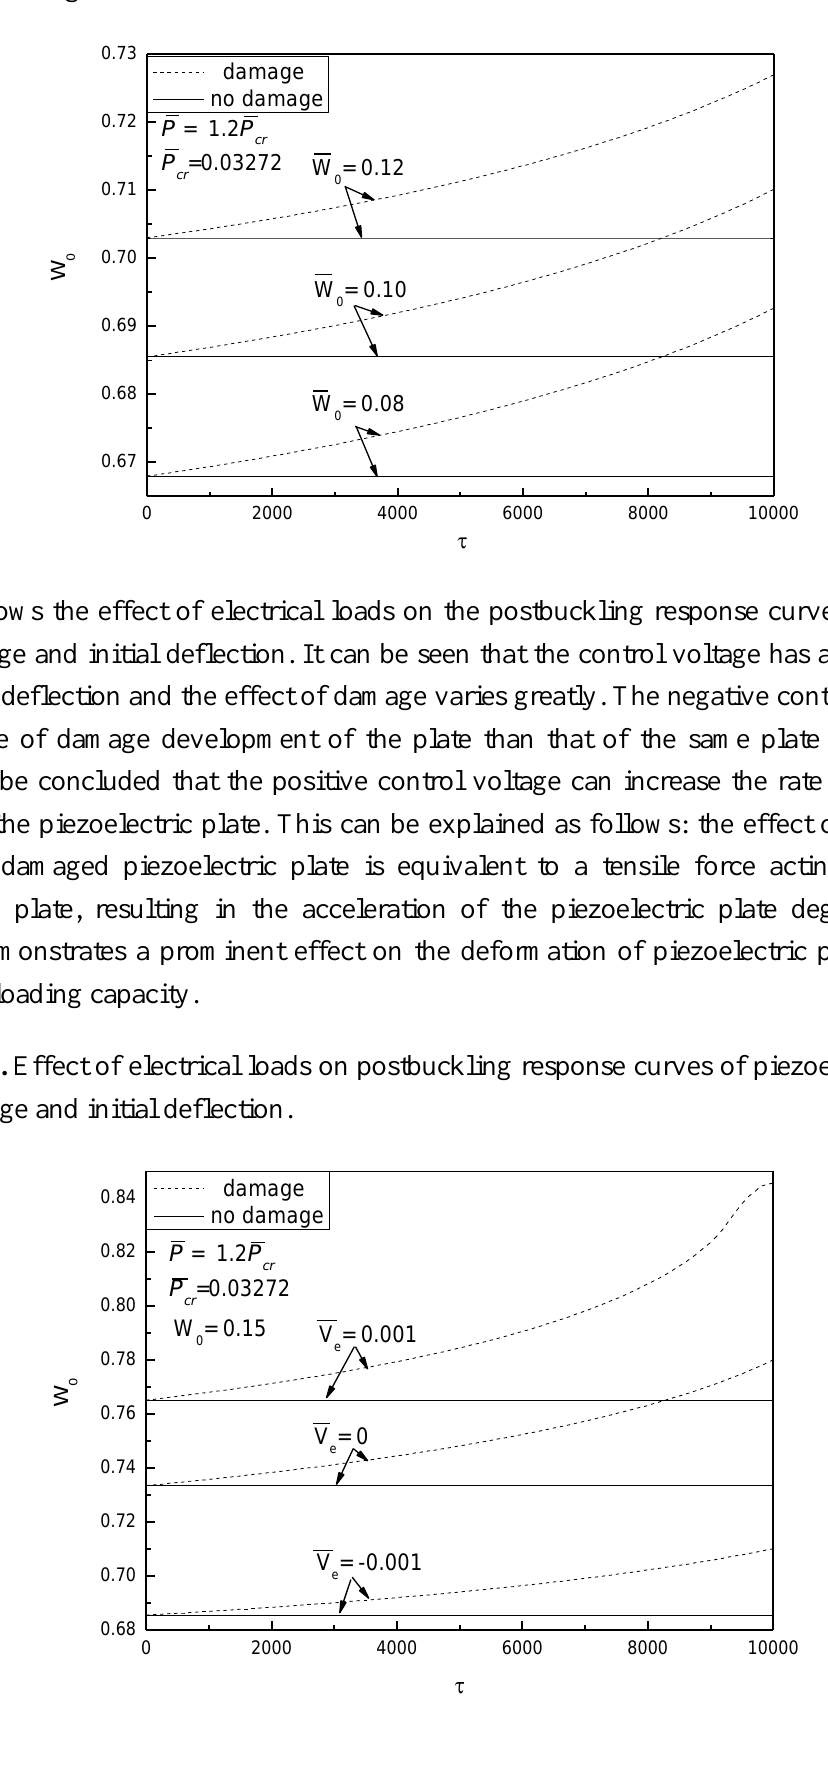
Figure 11. Effect of initial deflections on the postbuckling response curves of piezoelectric plate with damage.